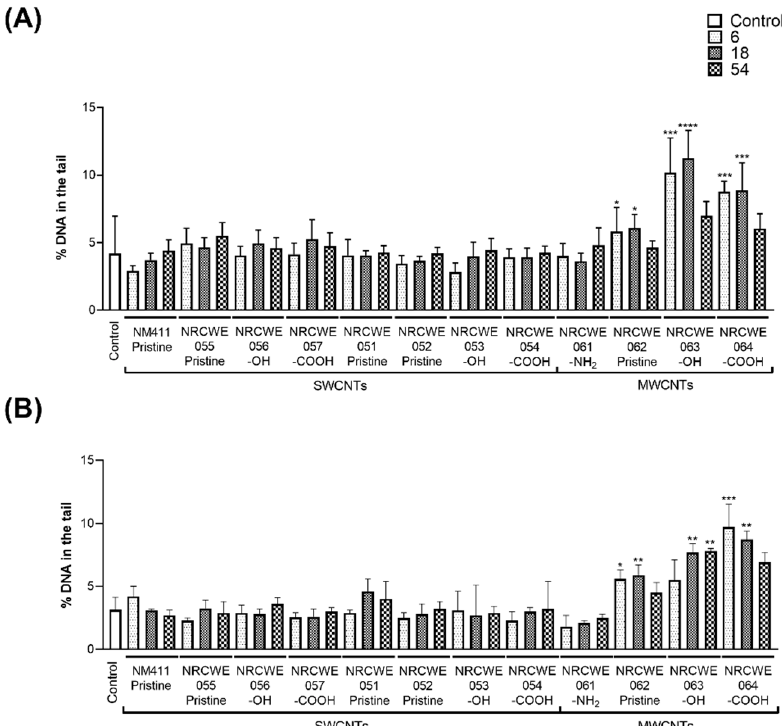
Figure 1. Percentage of DNA in the tail in BALF cells after exposure to individual SWCNTs or MWCNTs. Data represent median values with interquartile range. Statistically significant differences between exposed animals and controls were determined using the Kruskal–Wallis test with Dunn’s post-hoc. * p < 0.05, ** p < 0.01, *** p < 0.001, **** p < 0.0001. ( A ) Day 1; ( B ) Day 28. Different colors and fill patterns indicate different dose groups: control, 6 µ g/mouse, 18 µ g/mouse and 54 µ g/mouse of CNTs.